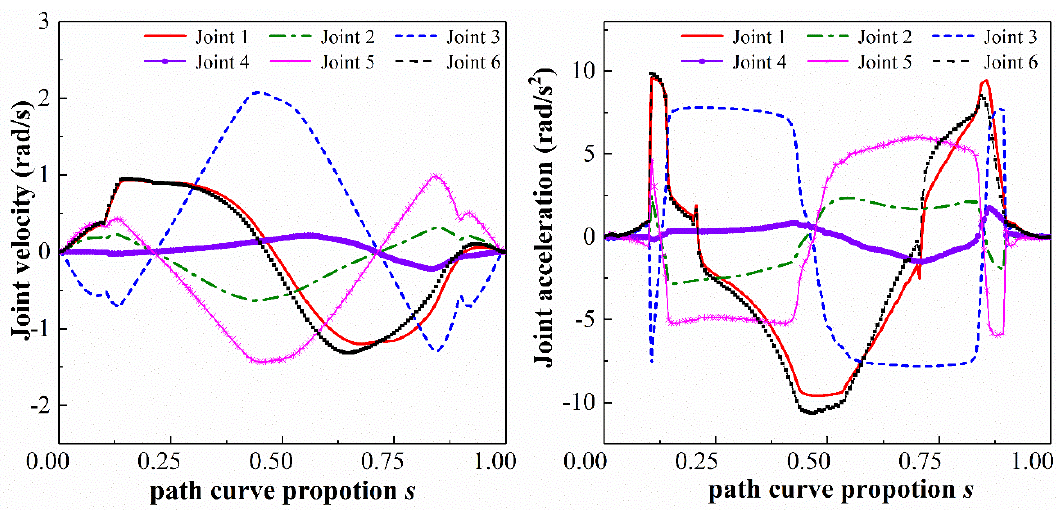
Figure 6. Optimized trajectories for robot joint with the proposed method. Table 3. Normalized energy consumption and motion time results obtained by the proposed opti- mization model.